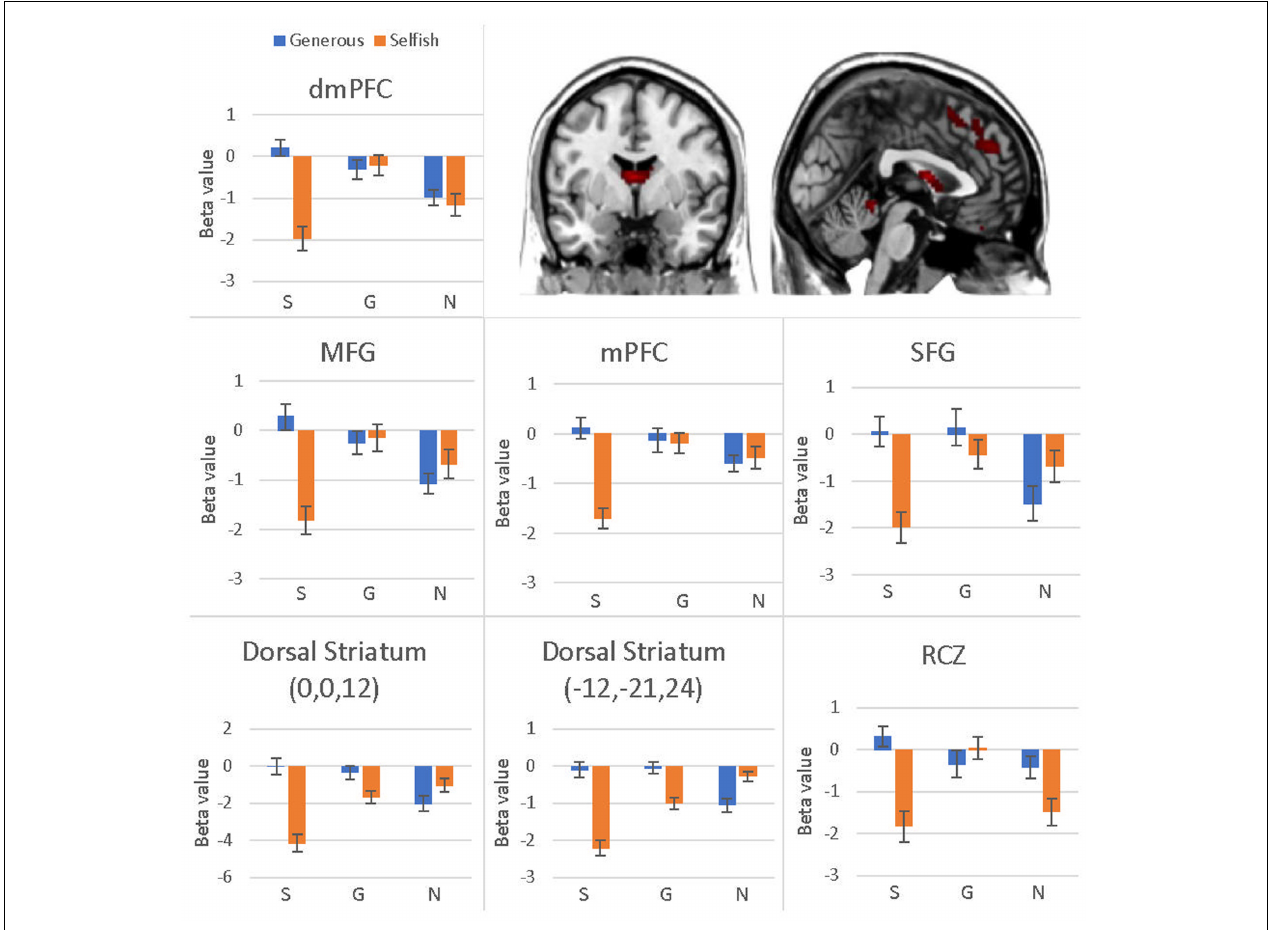
FIGURE 3 | Brain regions involved in the interaction effect between offer type and social influence, p < 0.05, cluster size = 10, FDR correction. Y -axis represents the beta value. G, generous influence; S, selfish influence; N, no social influence. (Error bars indicate standard errors of the